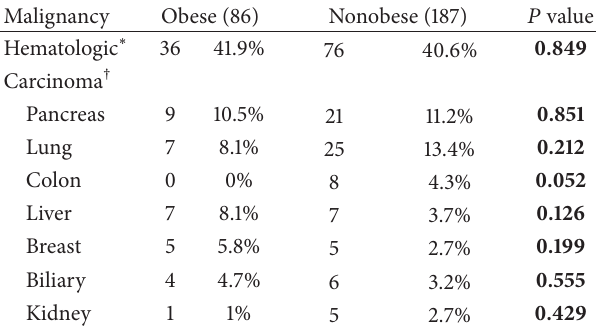
Table 3: Malignancy in different organ systems as a cause of death in obese and nonobese individuals.